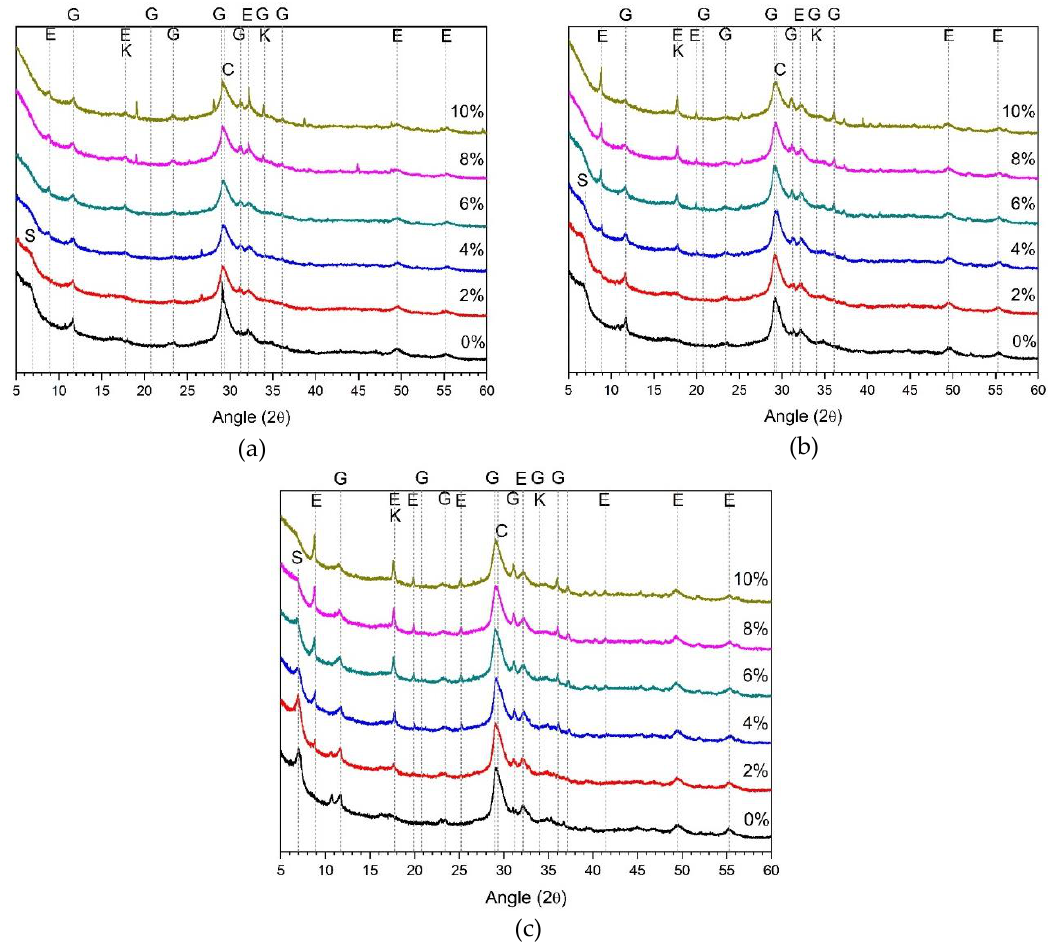
Figure 5. XRD analysis of 10% alkali with ALS after ( a ) 1 d, ( b ) 3 d, and ( c ) 28 d. E: ettringite; G: gypsum; C: C–S–H gel and calcite; S: strätlingite; K: katoite.